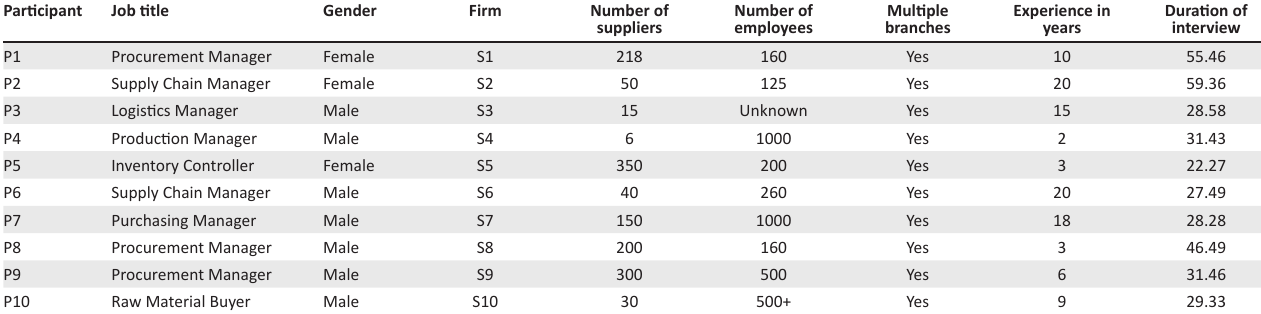
TABLE 2: Summary of participant and organisation